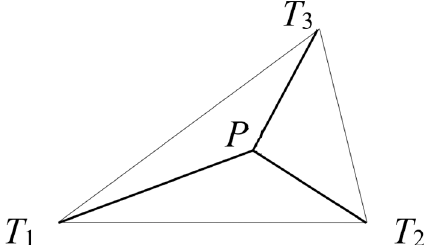
Figure 1. The Area Coordinate of Point P on the Coordinate Triangle.